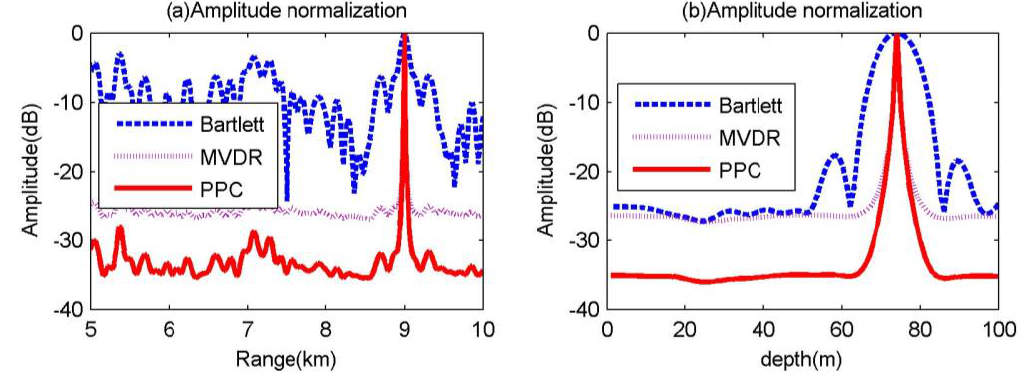
Figure 3. Slices of localization results for the three matched field processing (MFP) methods.